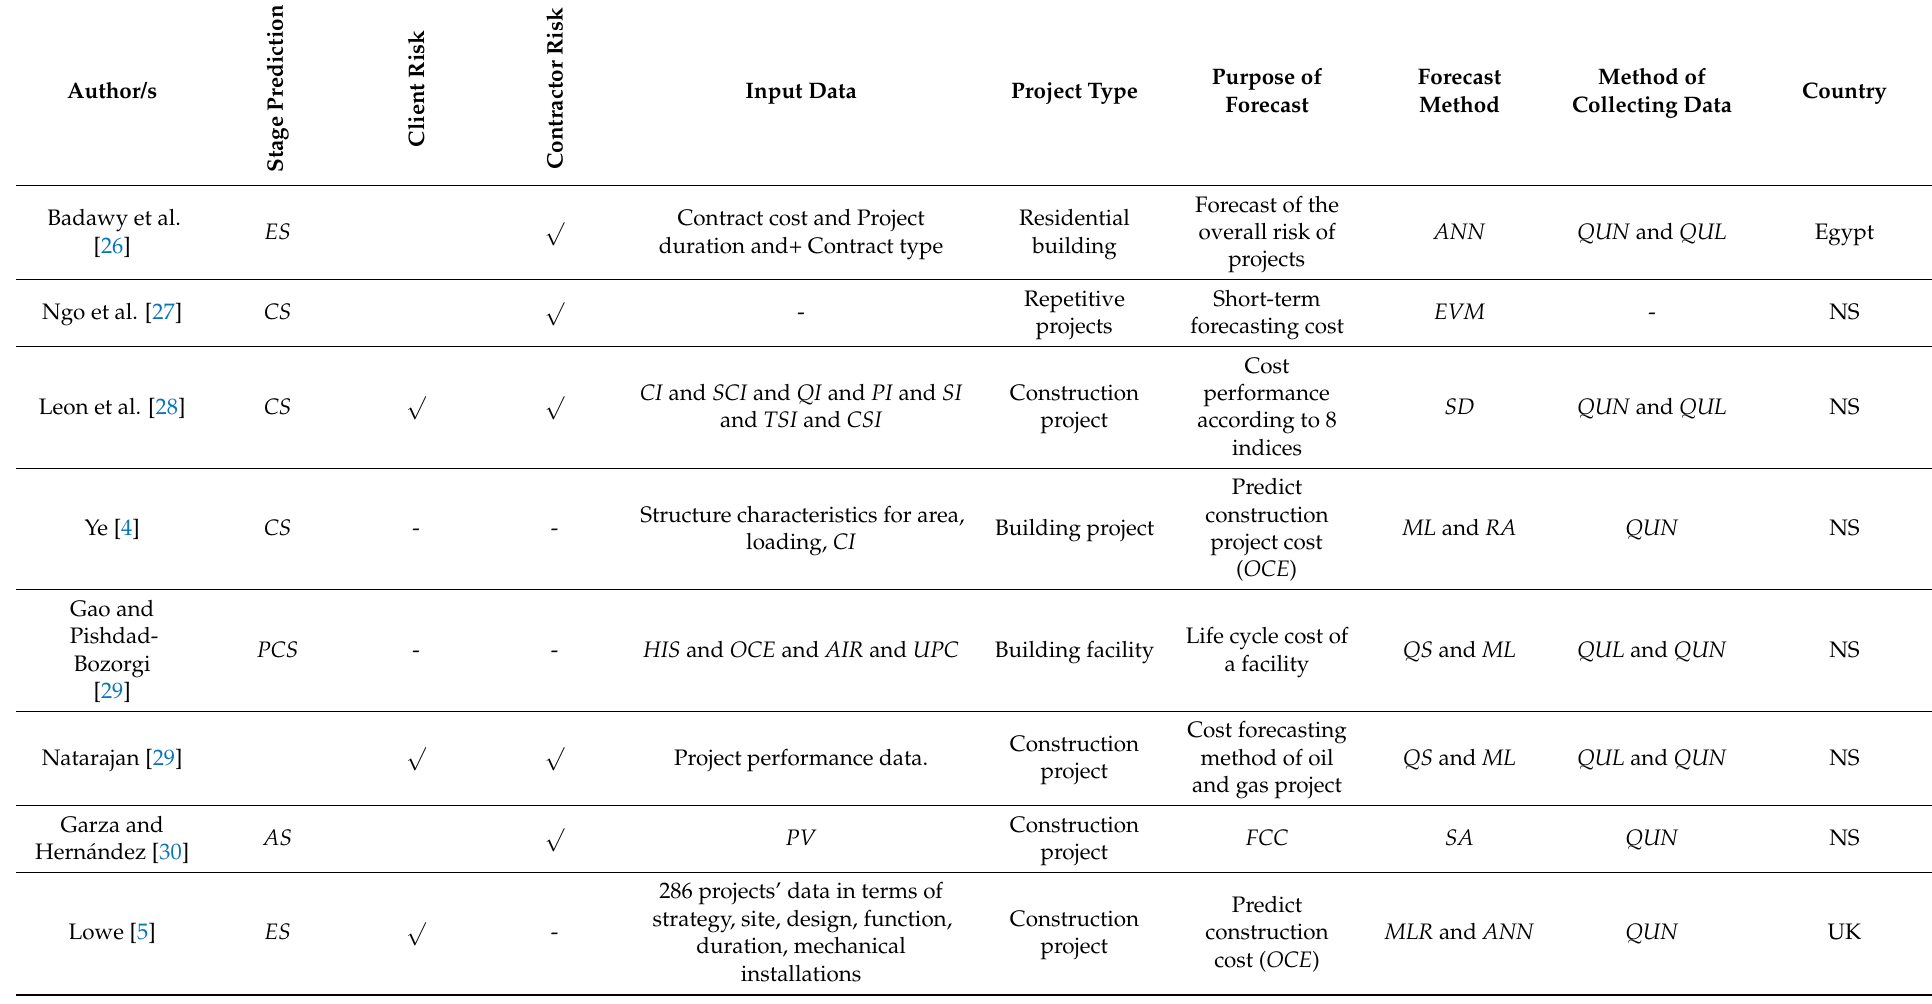
Table 1. Summary of methods used to determine the forecasted final contract